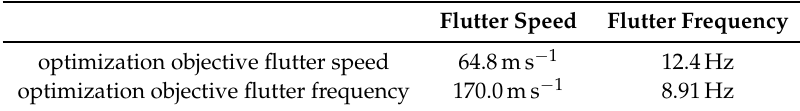
Table 3. Single objective optimization results.